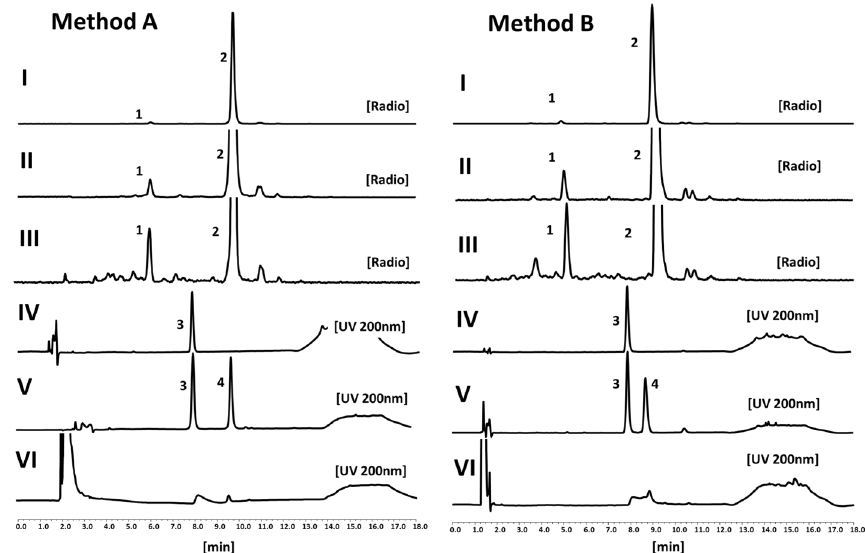
Fig. 1 Representative Chromatograms for PSMA I&T. Left: Method A, right: Method B, From top to bottom: I-Radiochromatogram of a test sample of [ 177 Lu]Lu-PSMA I&T with a radiochemical purity of about 96%; II- ~ 20 Zoom of radiochromatogram of test sample of [ 177 Lu]Lu-PSMA I&T; III-20 × radiochromatogram of test sample of [ 177 Lu]Lu-PSMA I&T stored at RT for 48 h; IV-UV trace of PSMA I&T standard 200 nm, V-UV trace of a mixture of PSMA I&T and nat Lu-PSMA I&T UV 200 nm; VI- UV-chromatogram of a test sample of [ 177 Lu]Lu-PSMA I&T. Peak labels: 1: main radiochemical impurity; 2: [ 177 Lu]Lu-PSMA I&T; 3: PSMA I&T; 4: nat Lu-PSMA